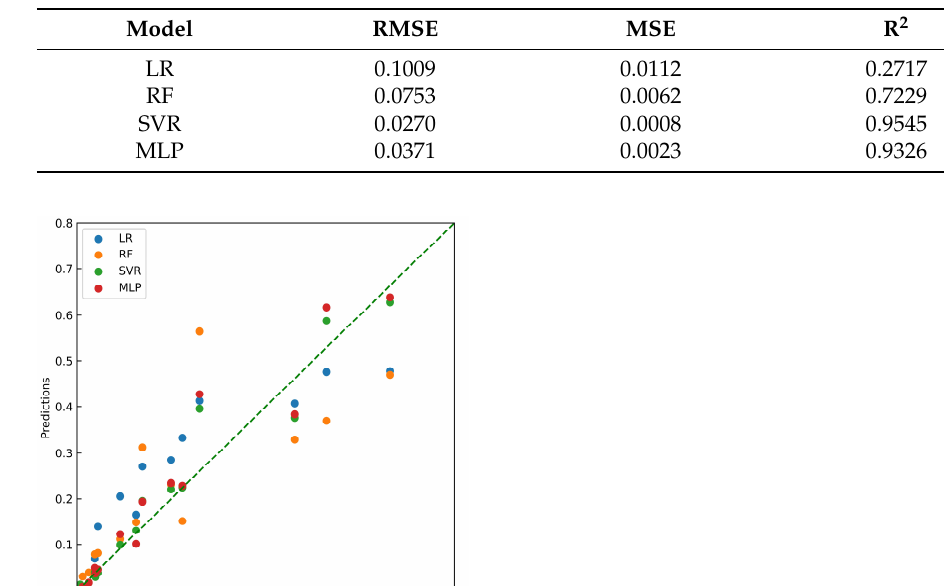
Table 4. Performance evaluation of proposed regression models.